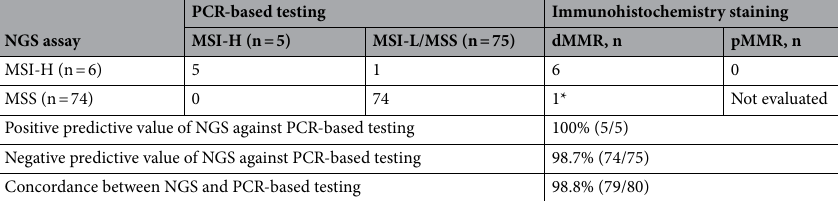
Table 3. Concordance and discordance of microsatellite instability status between next-generation sequencing (NGS) and polymerase chain reaction (PCR)-based testing. dMMR deficient mismatch repair;